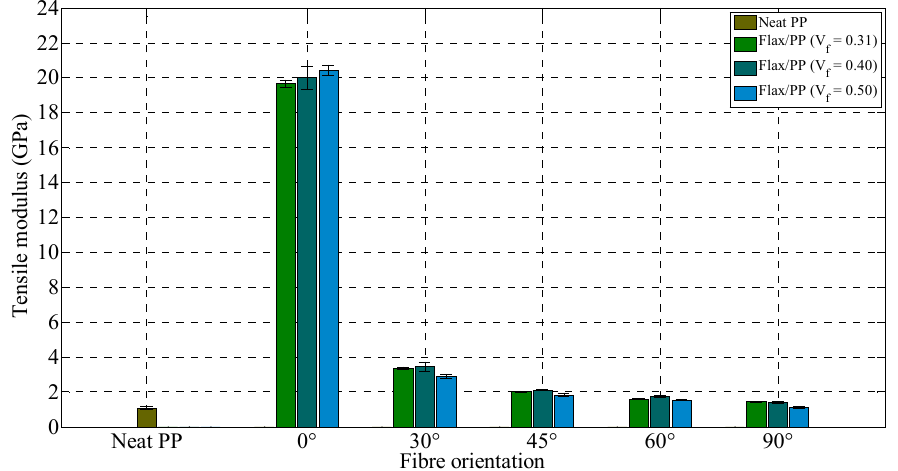
Figure 12. Tensile modulus for neat PP and flax/PP samples of different fibre volume fractions and orientations.